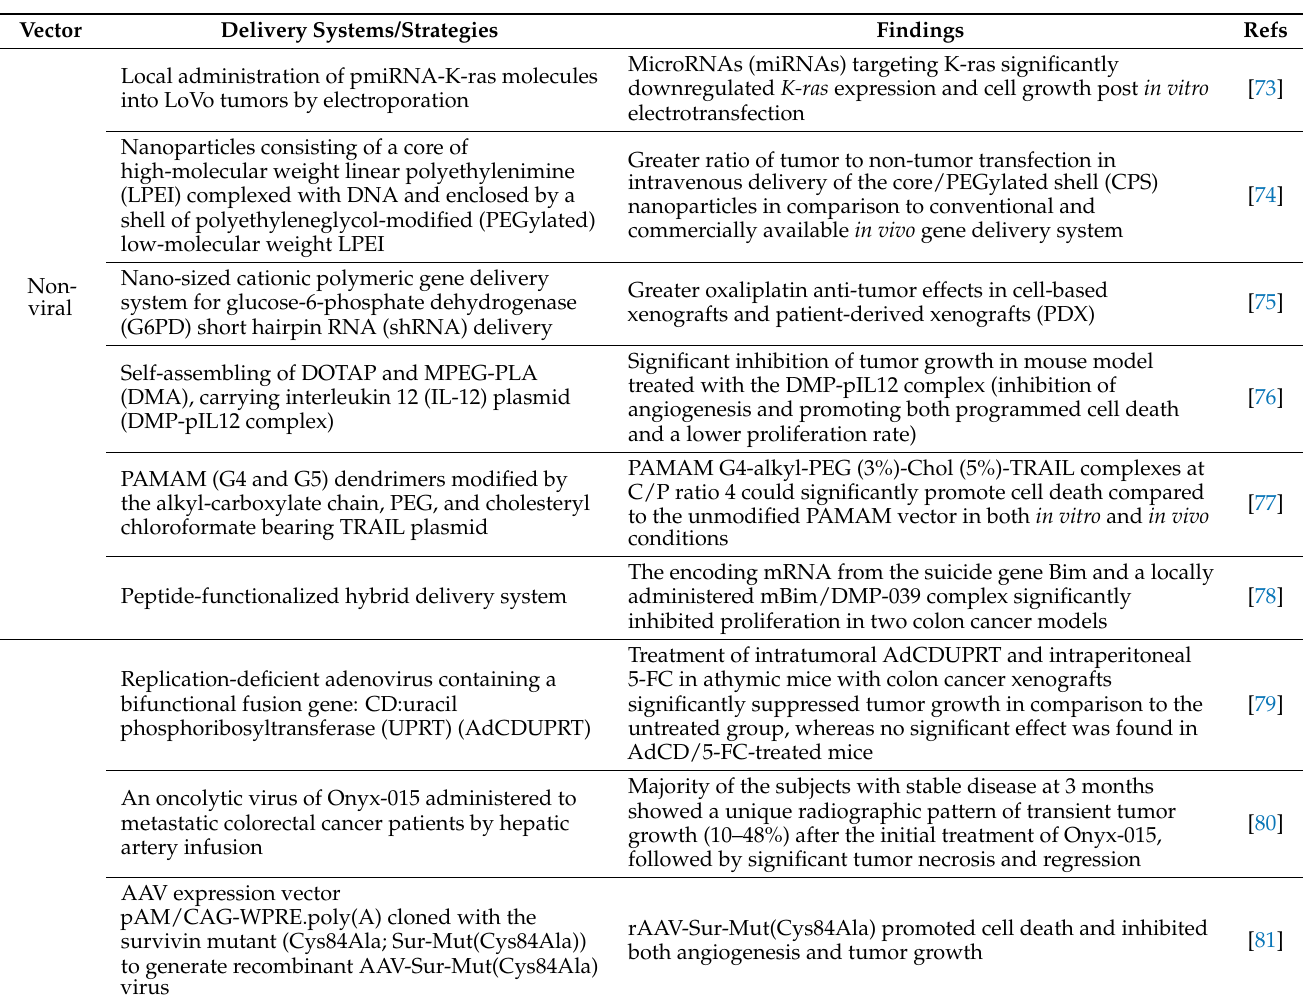
Table 2. Viral and non-viral delivery approaches for CRC gene